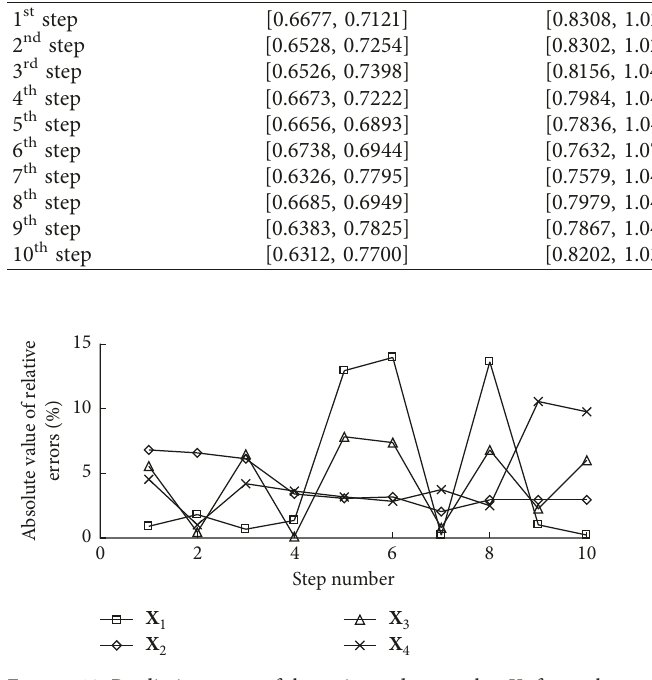
Figure 12: Prediction error of the estimated true value X subseries. Table 4: Number of μ exceeding the threshold h and variation intensity θ .